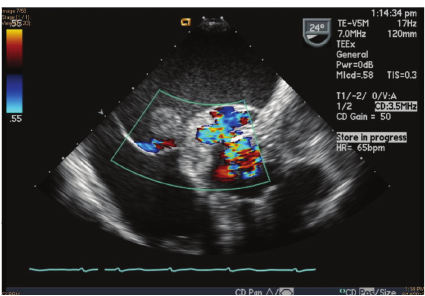
Figure 2: Transesophageal echocardiogram in short axis view with colorflowDopplershowingbloodflowfromthebioprostheticaortic valve, into the aortic root abscess, which has ruptured into the left atrium, forming an aortico-left atrial fistula.